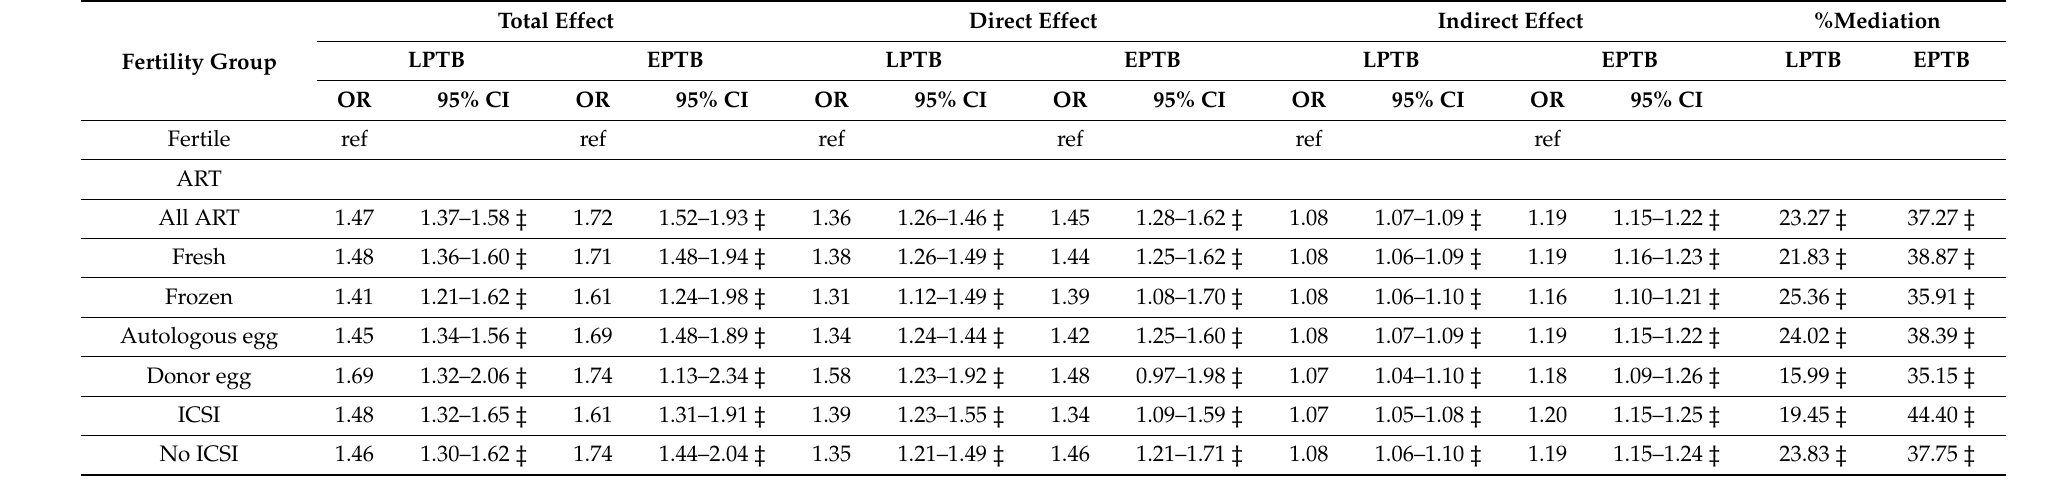
Table 3. Mediation analysis with Placental abnormalities as